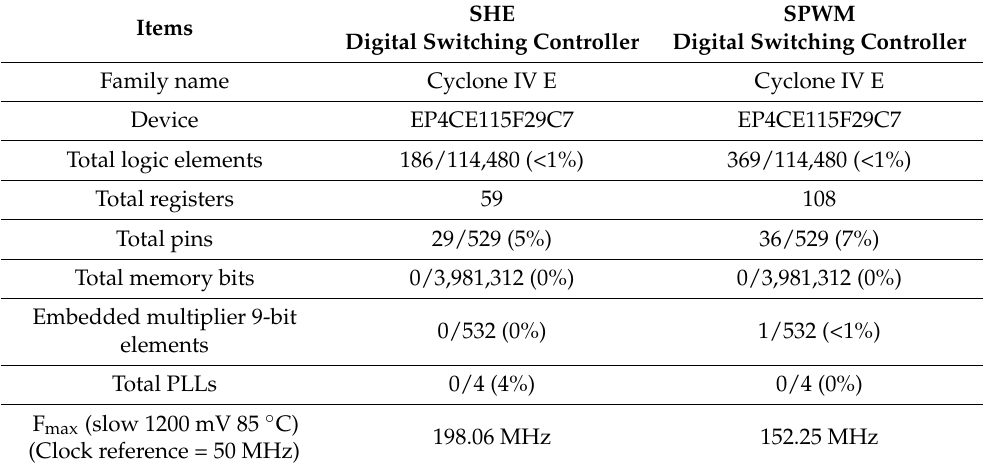
Table 7. Synthesis summary report of SHE and SPWM digital switching controllers using the Intel field-programmable gate array (FPGA) (Cyclone IV E)